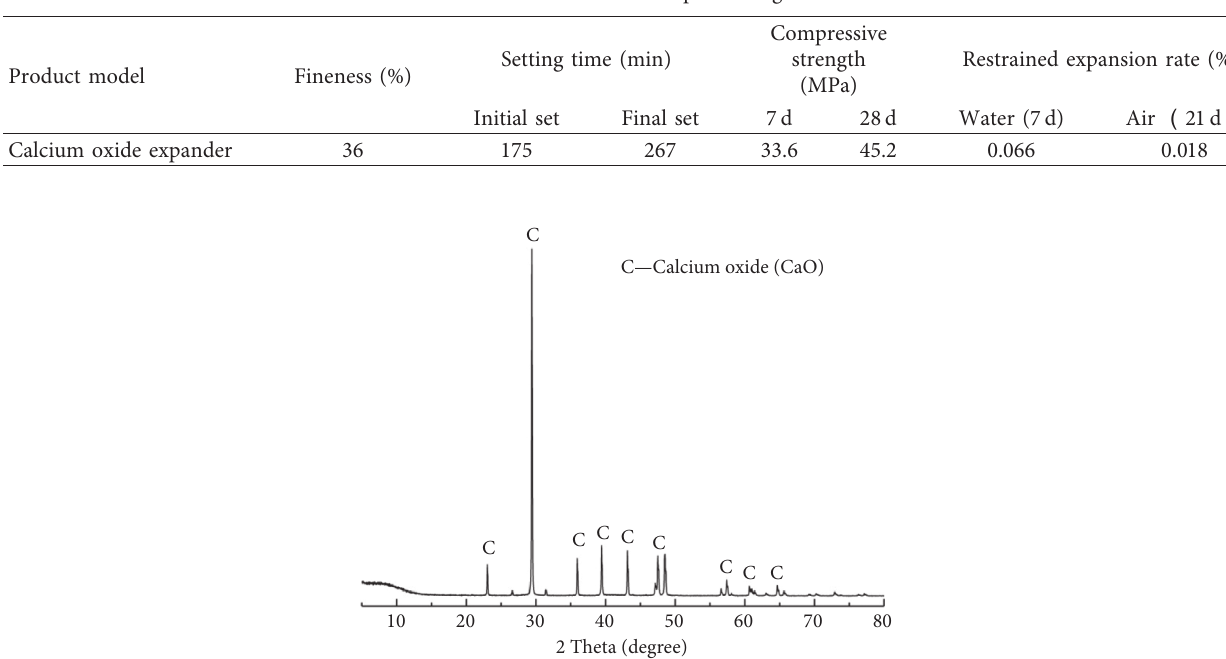
Table 3: Calcium oxide expansion agent.